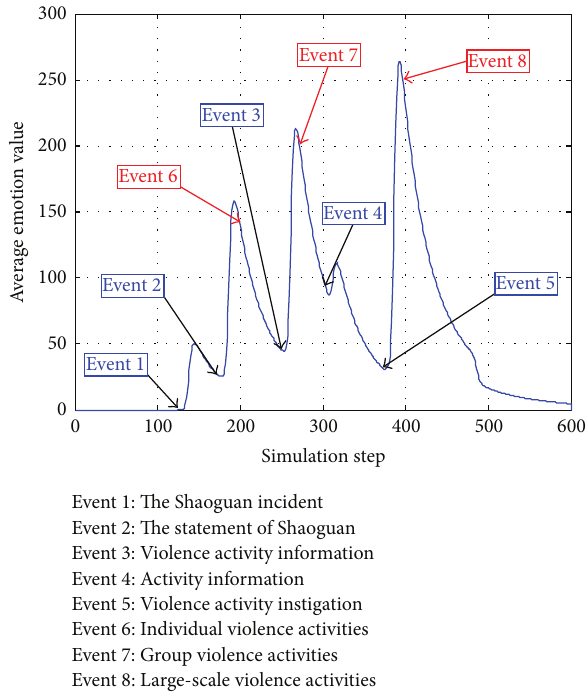
Figure 8: Group emotion evolution and events in the case